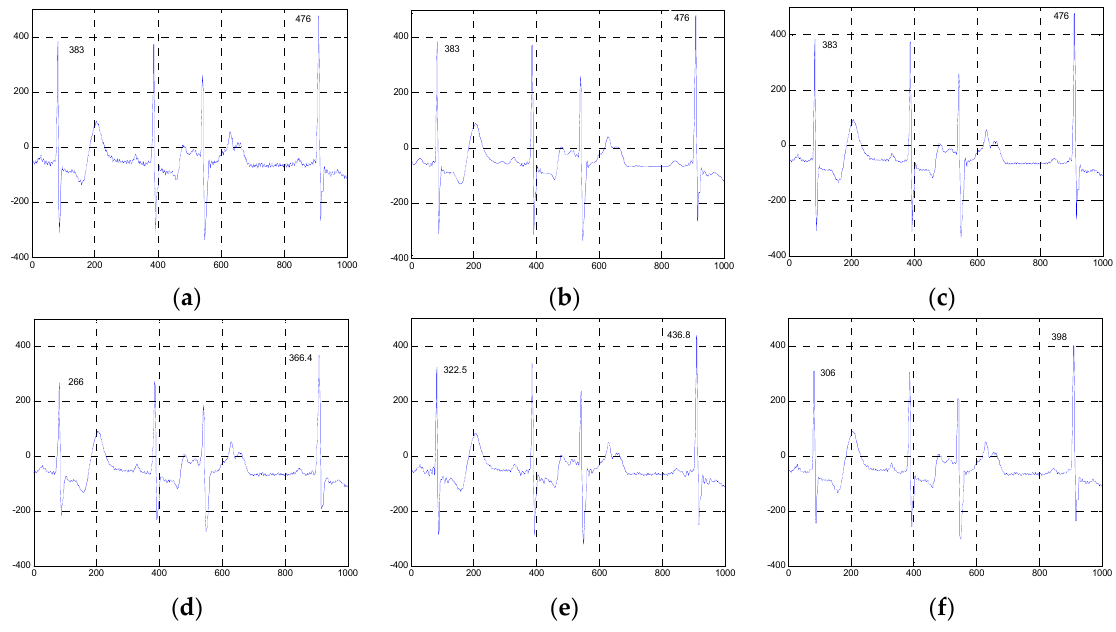
Figure 12. Comparison of the denoised results for the ESMD-NLM, NLM, EEMD, VMD and MED methods operating on the 13420_12m.dat in the third group of clinical ECG signals. ( a ) The clinical ECG signal, ( b ) the ESMD-NLM method, ( c ) the NLM method, ( d ) the EEMD method, ( e ) the VMD method, ( f ) the MED filter.